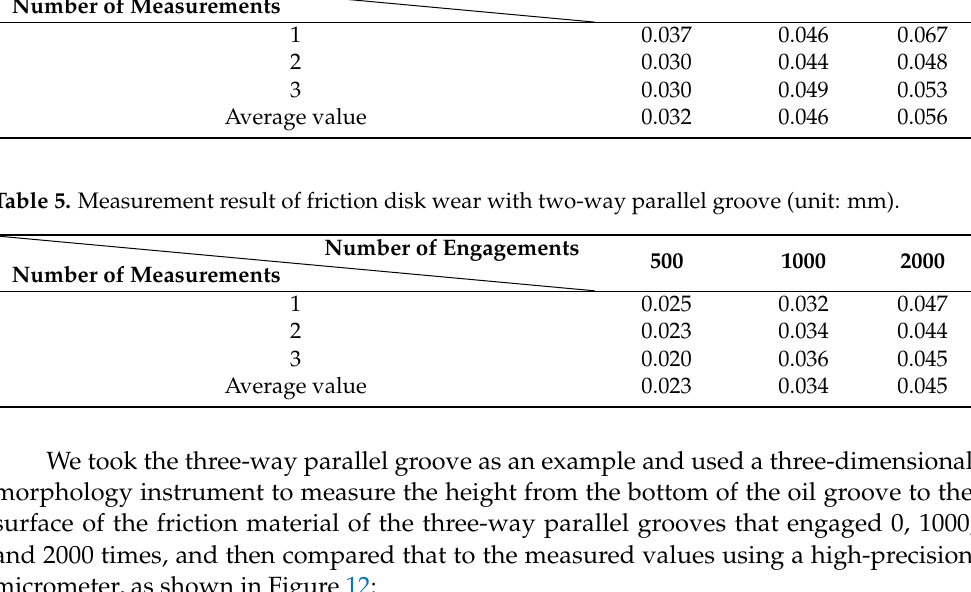
Table 4. Measurement results of the friction disk wear with waffle grooves (unit: mm). Number of Measurements